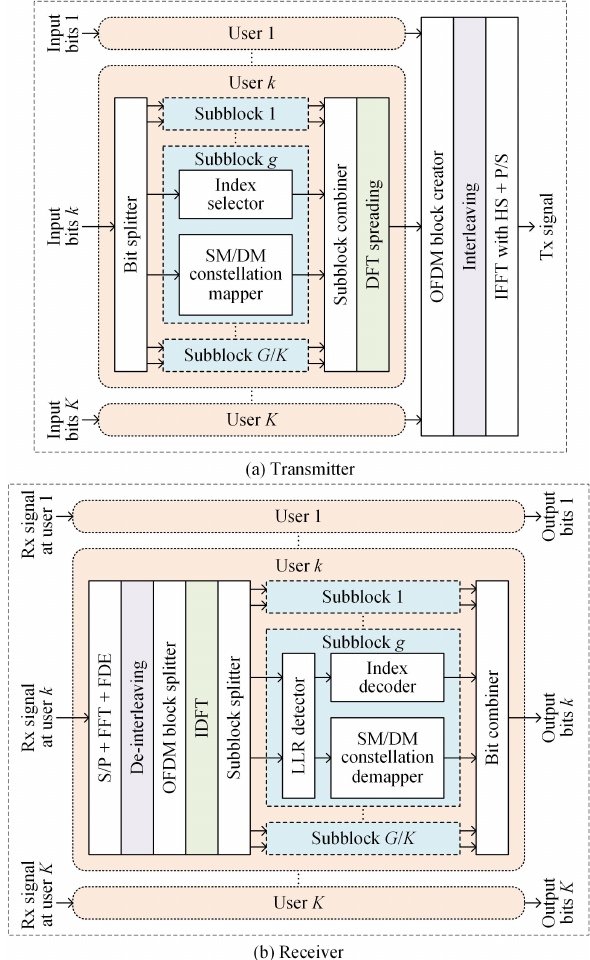
Figure 1. Block diagrams of the K -user OSDMA-MU-VLC system with DFT-spreading and interleav- ing: ( a ) transmitter and ( b )